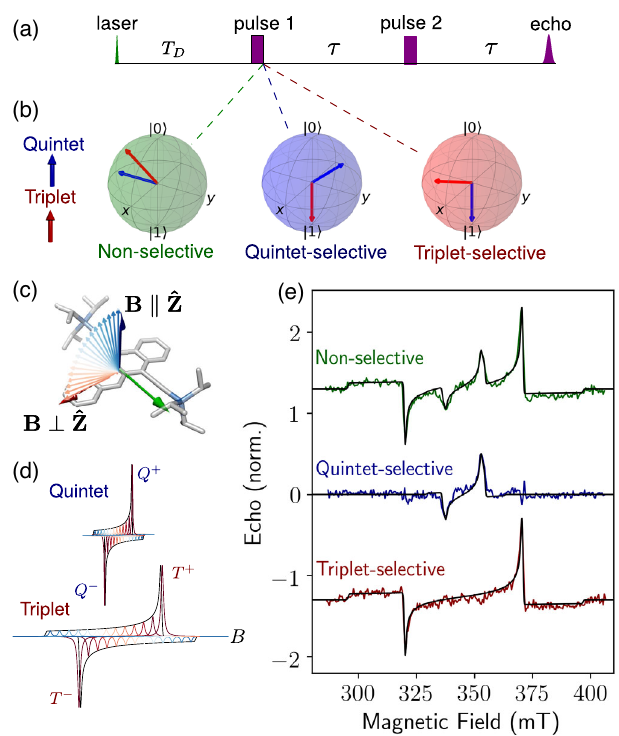
FIG. 2. Spectral separation of fission-borne spin states in a thin film. (a) Spin-echo pulse sequence. The length of pulse 1 determines which spin multiplicity is selected in the echo- detected field-swept spectra by rotating triplet (red), quintet (blue), or neither state (green) onto the pole of the Bloch sphere, as depicted in (b). (c) Distribution of the magnetic field B relative to the molecular axes of TIPS-tetracene for a randomly oriented film with (d) corresponding ESR transitions from the j 0 i sublevel of the S ¼ 2 quintet states (top) and S ¼ 1 triplet states (bottom). ≃ 0 . 5 μ s with (e) Spin-echo-detected spectra measured at T D nonselective (green), quintet-selective (blue), and triplet-selective (red) pulse sequences, demonstrating coherent separation of quintet and triplet states. Corresponding simulations are shown in black